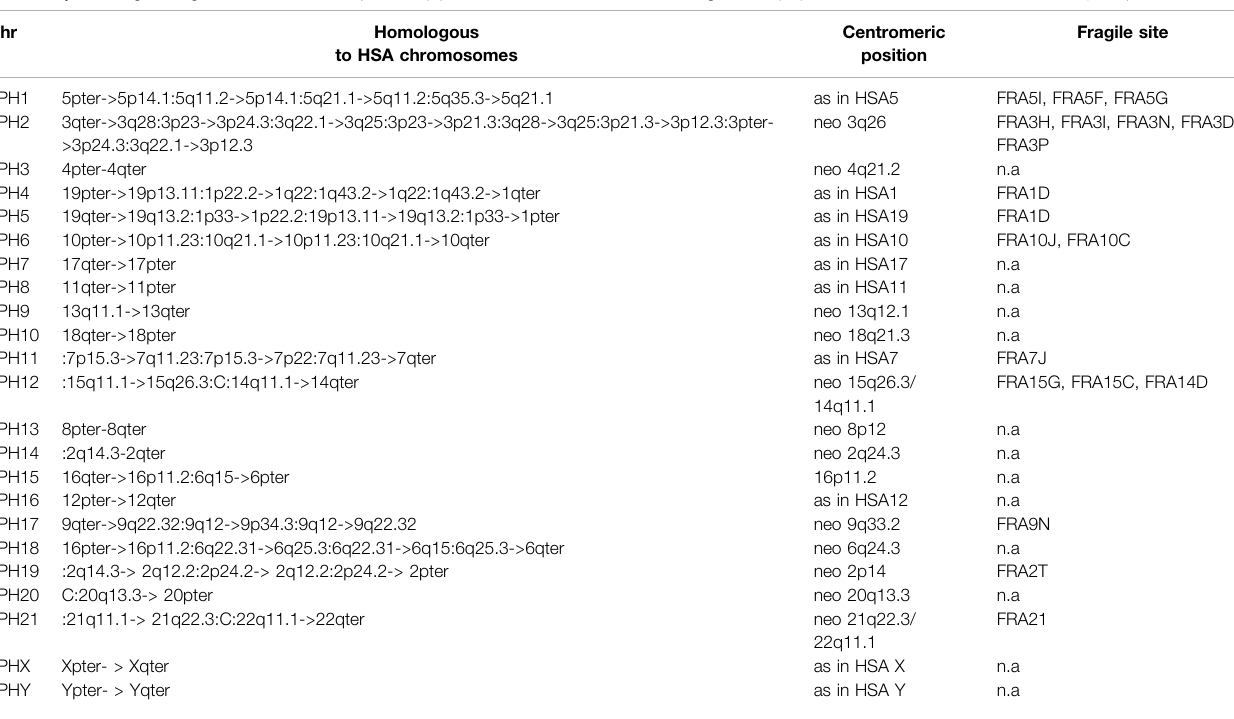
TABLE 1 | Homologous regions, the centromere position (C), and colocalization with human fragile sites (FS). FSs are listed acc. to Mrasek et al.